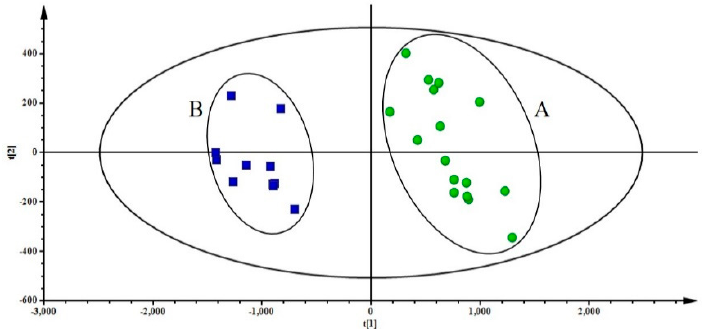
Figure 3. The PCA chromatogram of Chuan maidong (CMD) ( A ) and Zhe maidong (ZMD) ( B ).